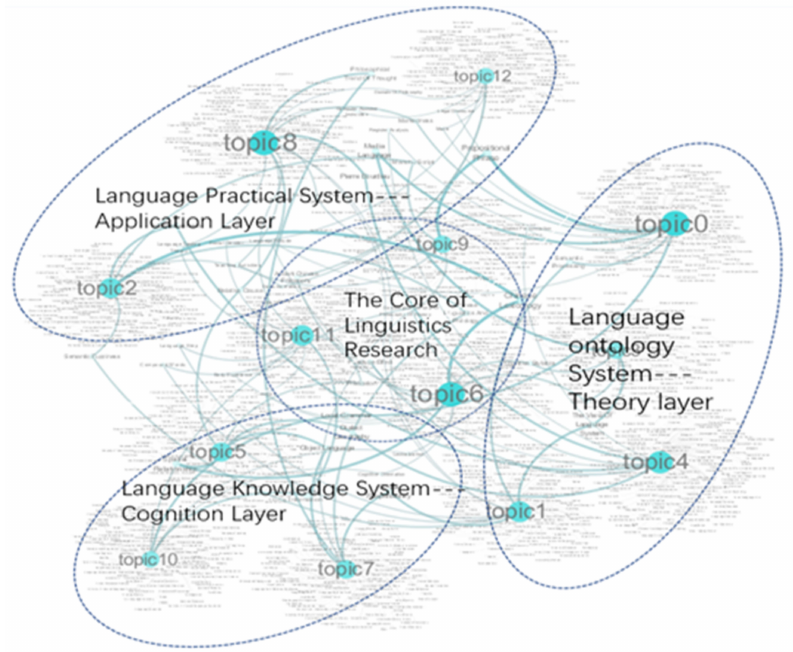
Figure 8. A structural map of linguistic research topics in China. Note: see Appendix A below for a partial enlargement of the image, which highlights topic 6: linguistic cognition and